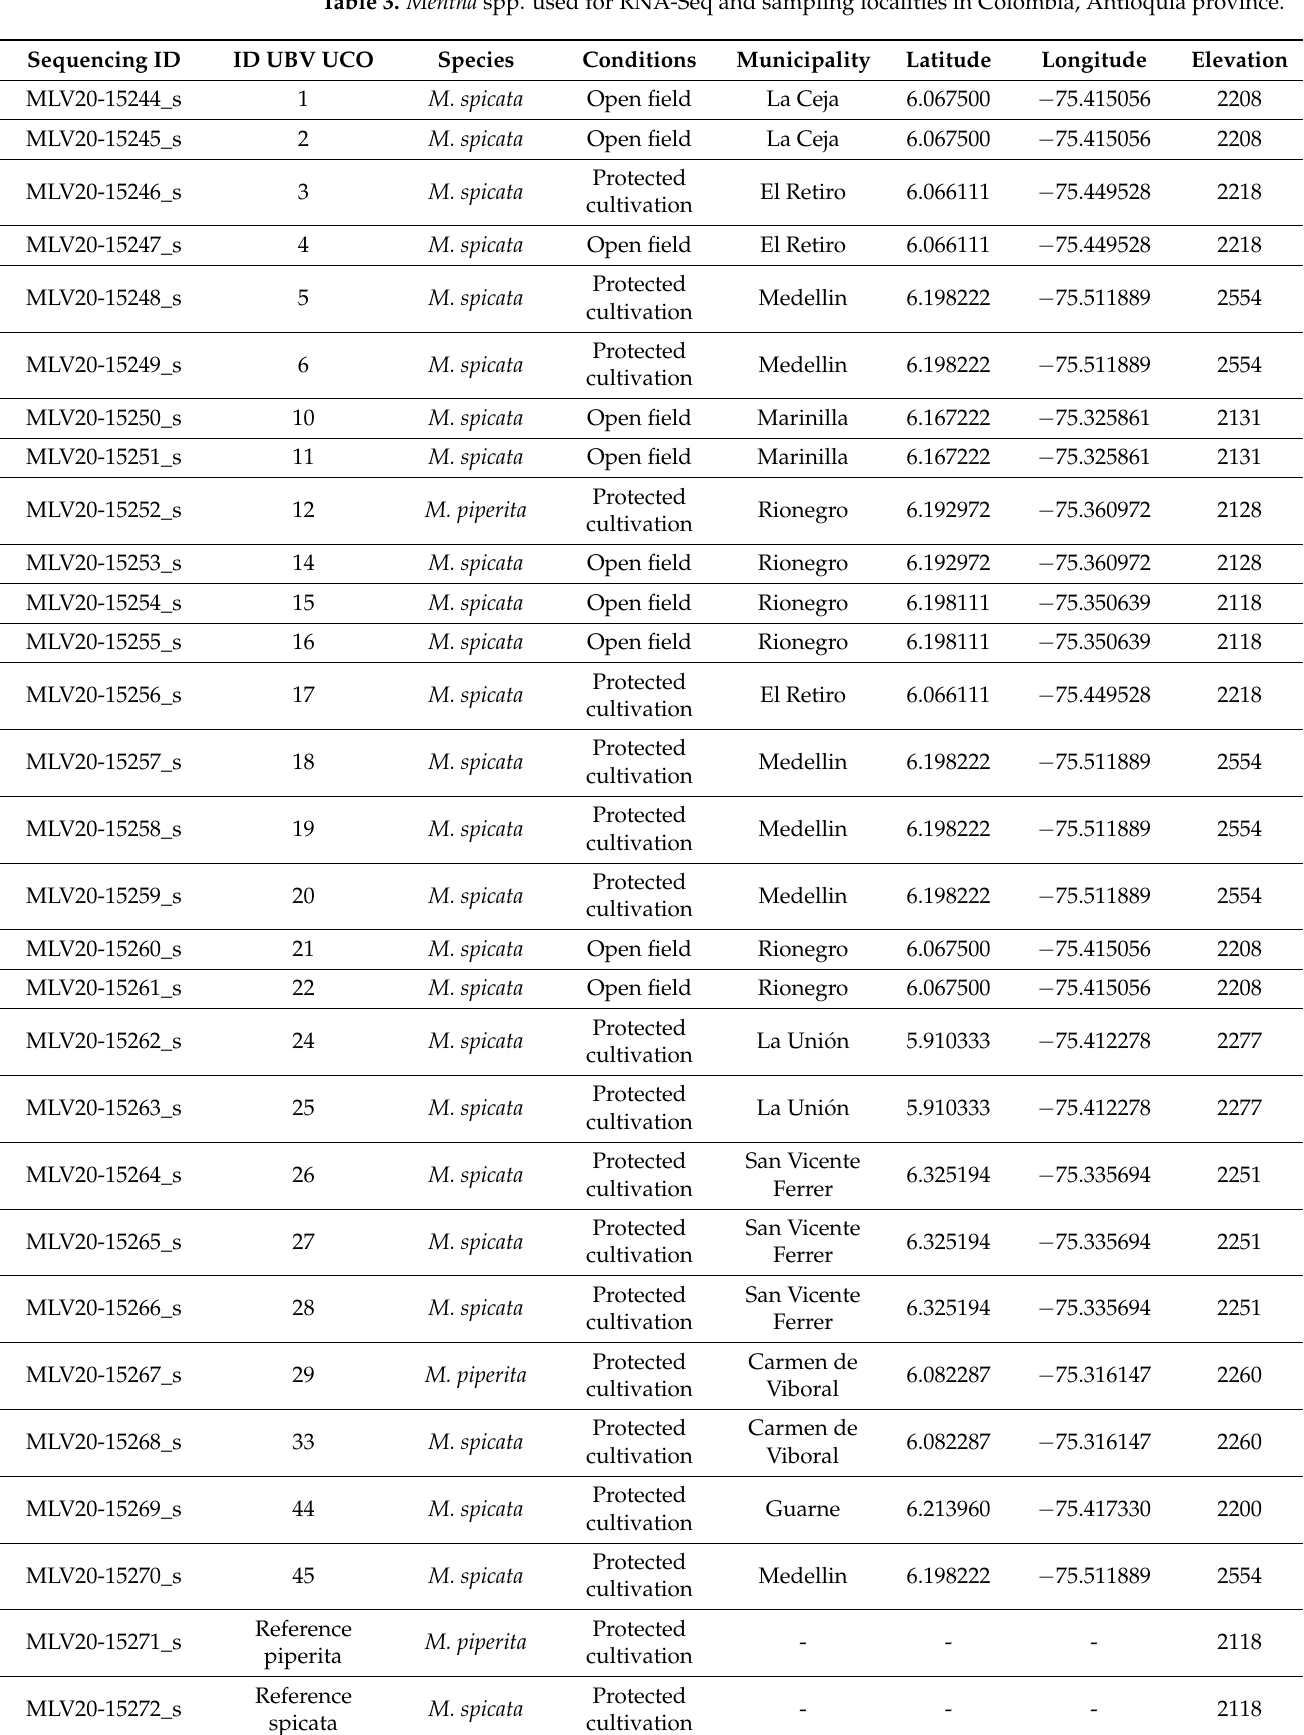
Table 3. Mentha spp. used for RNA-Seq and sampling localities in Colombia, Antioquia